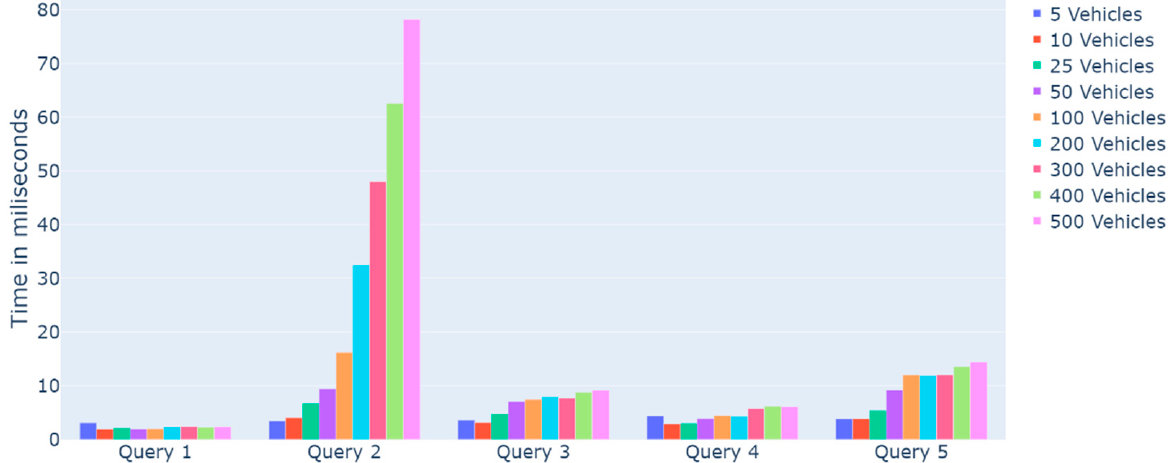
Figure 11. Bar plot with querying time in milliseconds of the different numbers of vehicles for different queries.